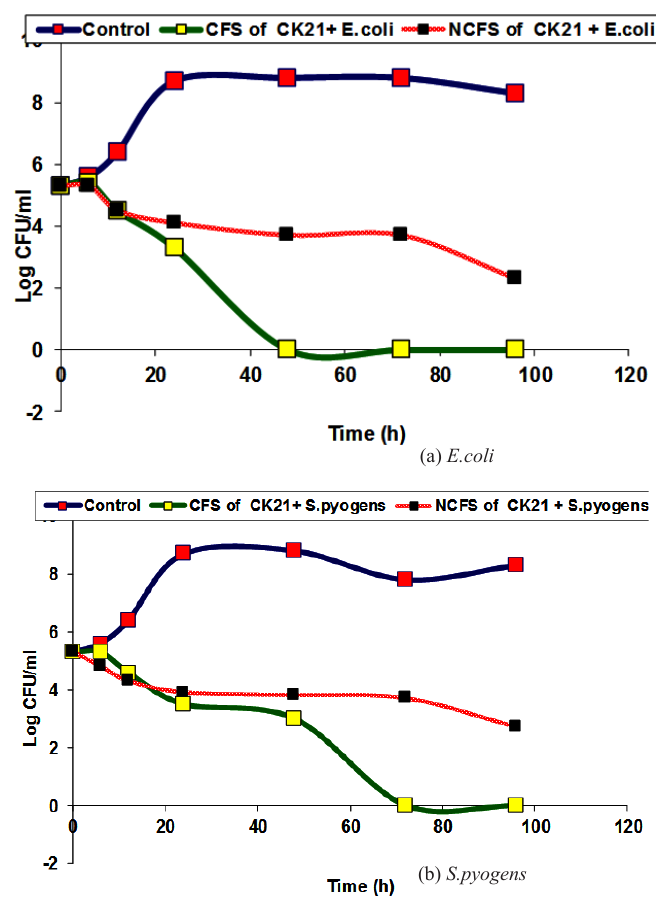
Fig. 6. Inhibition of E.coli and S.pyogens by NCFS and CFS from CK21